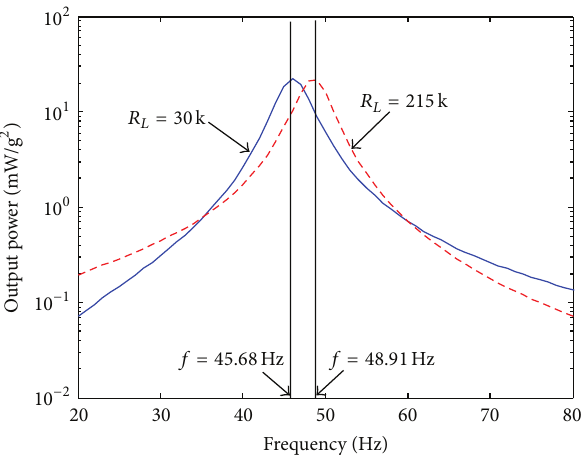
Figure 11: Variation in output power of the PVEH with excitation frequencies for two optimum load